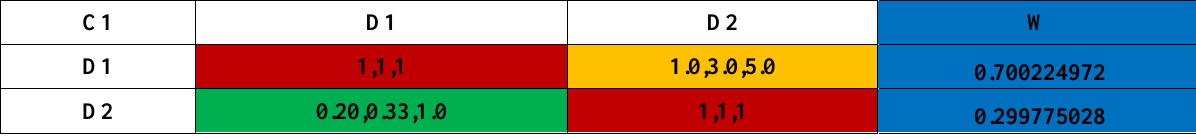
Table 9. The pairwise comparison matrix, C